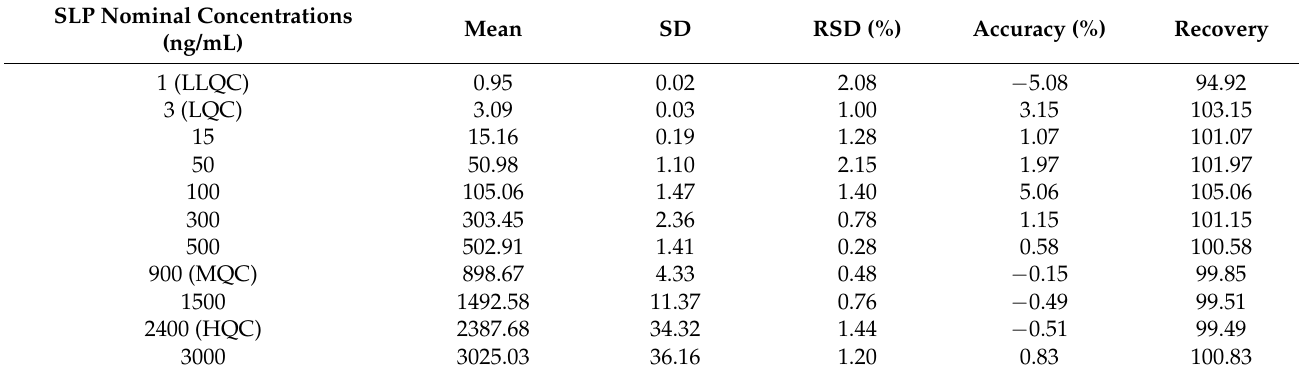
Table 1. Back-calculation results of six replicates (eleven standards) of SLP.